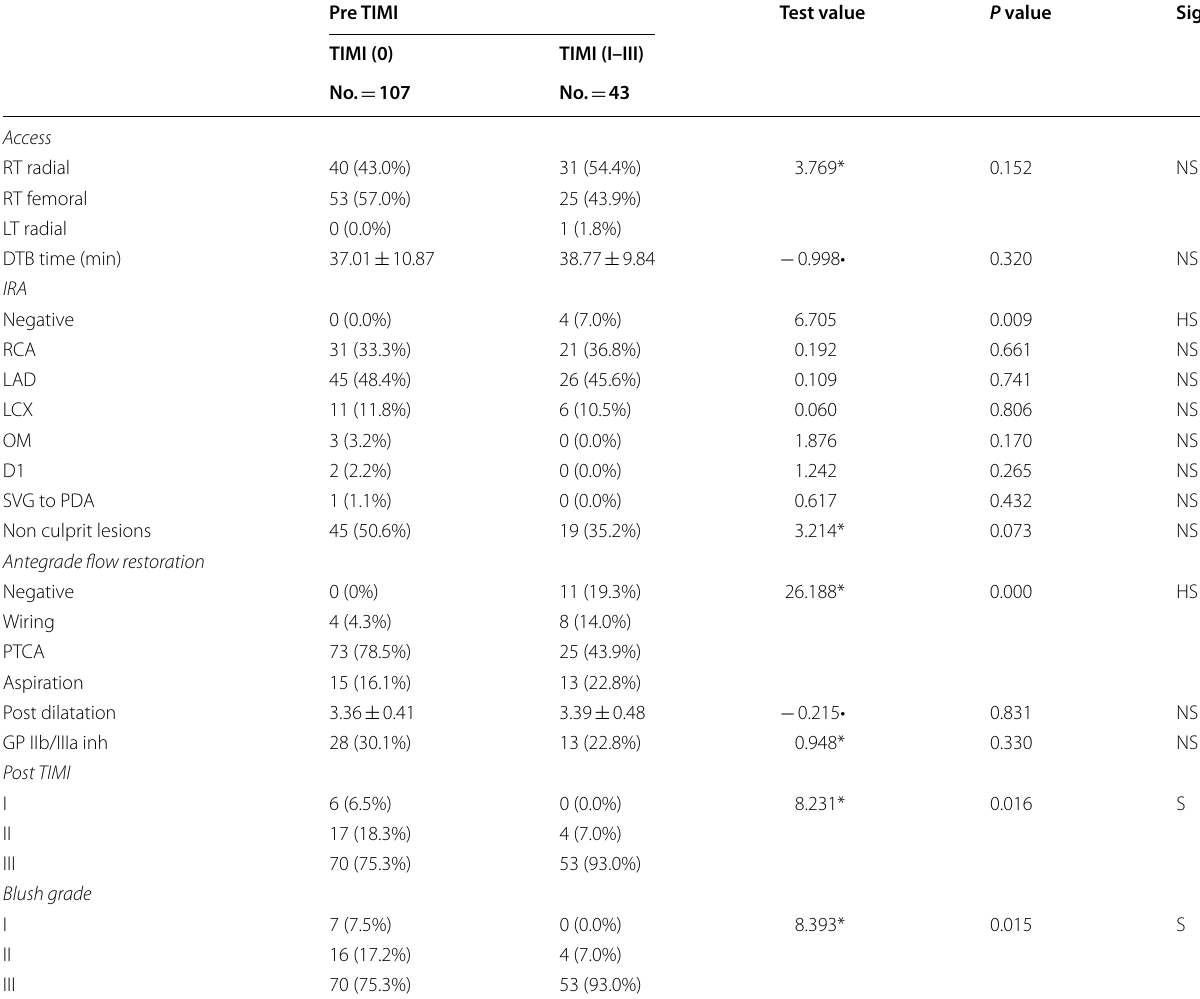
Table 3 Relation between pre TIMI flow grade with procedural data of the studied